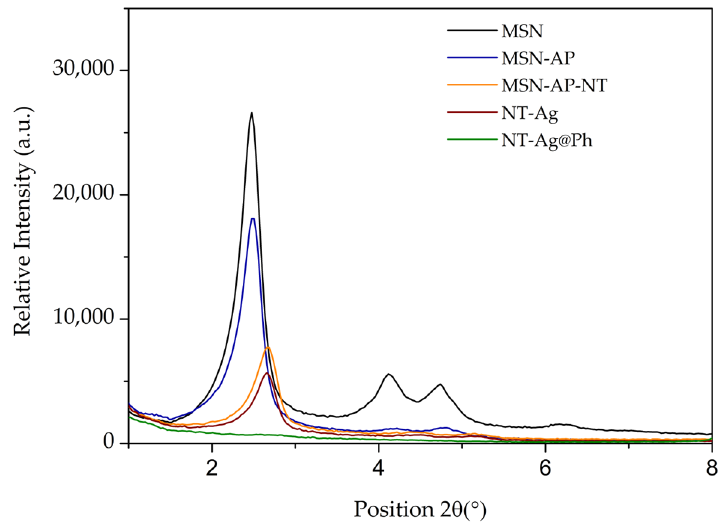
Figure 2. Small-angle XRD patterns of all materials.